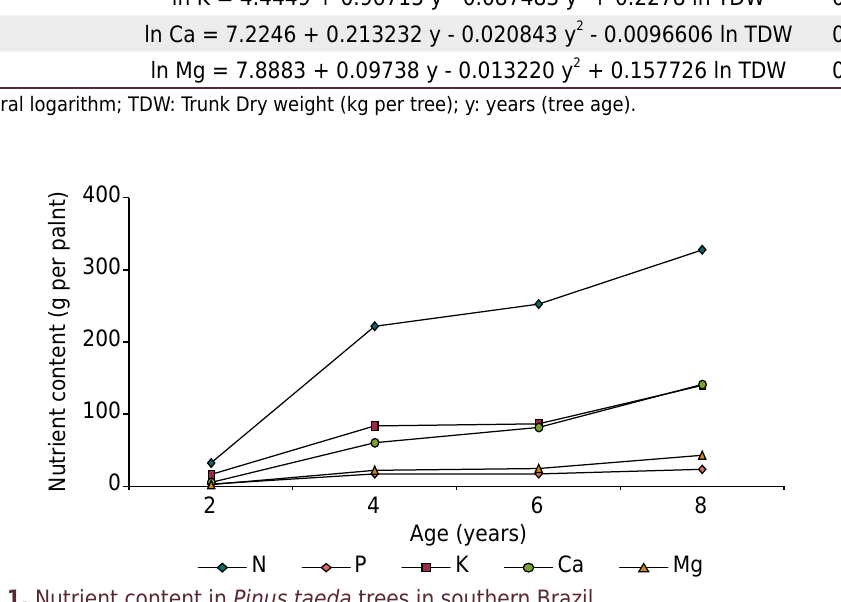
Figure 1. Nutrient content in Pinus taeda trees in southern